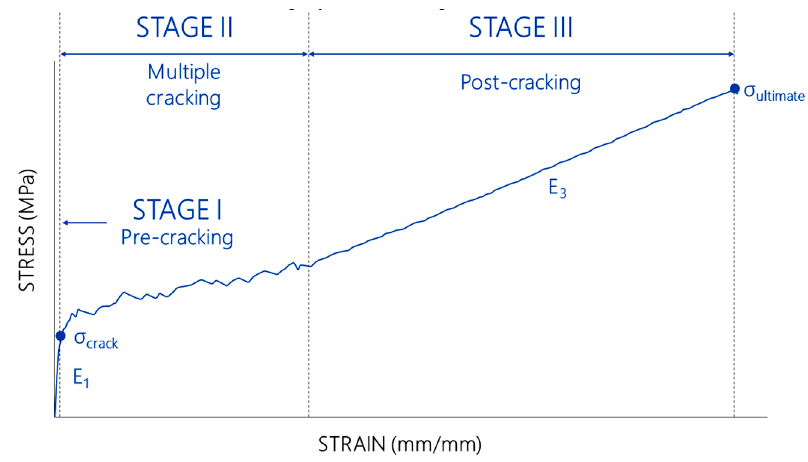
Figure 1. Characteristic tensile behavior of textile reinforced cementitious composite (TRC).